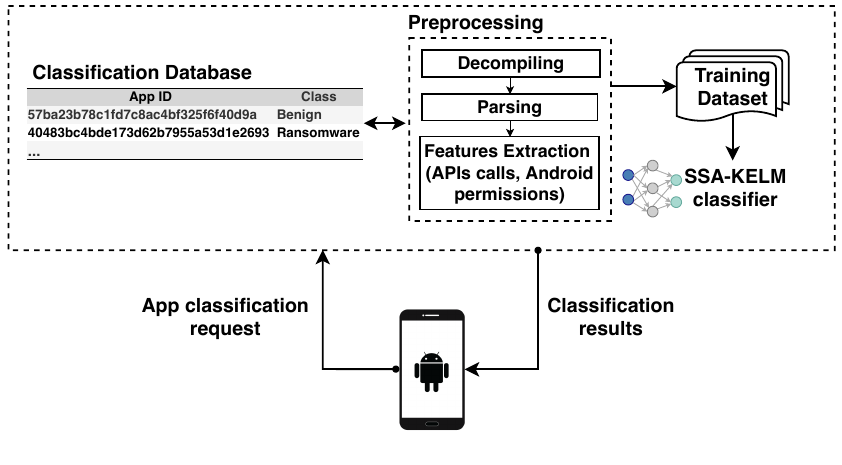
Figure 3. An illustration of an intelligent Android ransomware detection